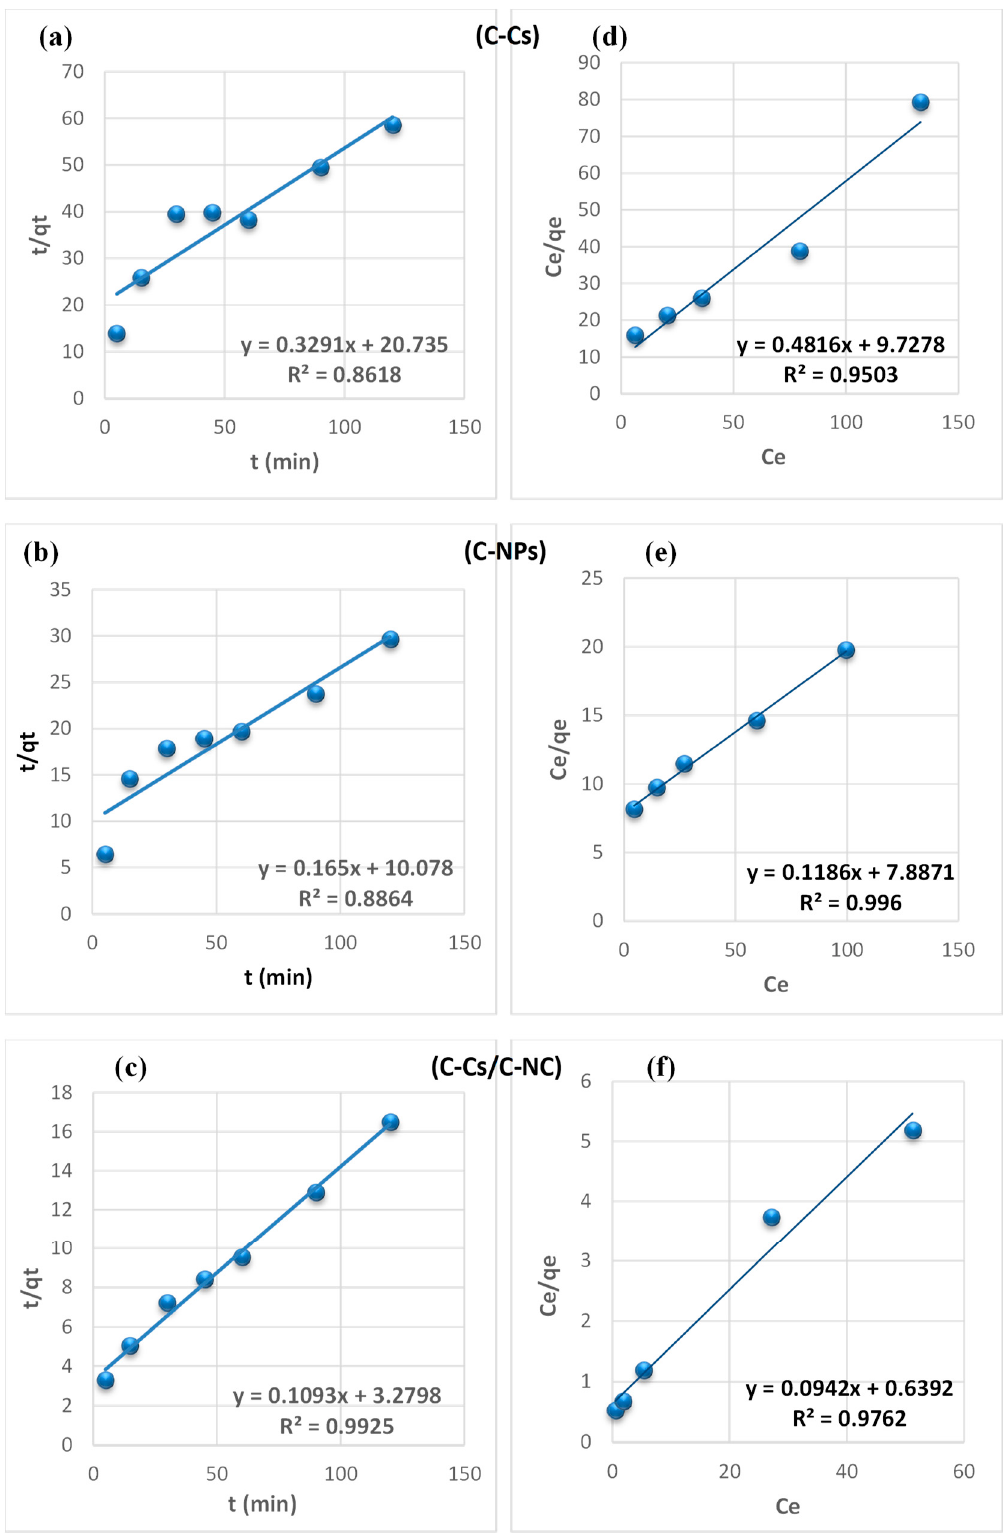
Figure 7. Pseudo-second-order fitting model ( a – c ) and Langmuir isothermal fitting model ( d – f ) of the removal of lead ions using C-Cs, C-NPs, and C-Cs/C-NC, respectively.